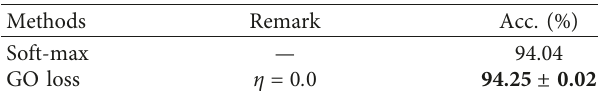
Table 4: Classification accuracy with WRN-28 on Fashion-MNIST